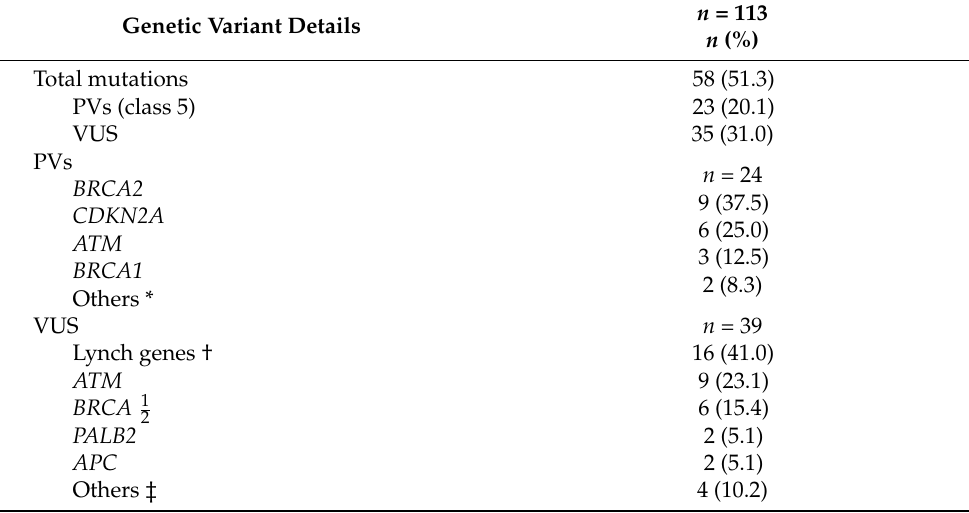
Table 3. Genetic variants in the study population.